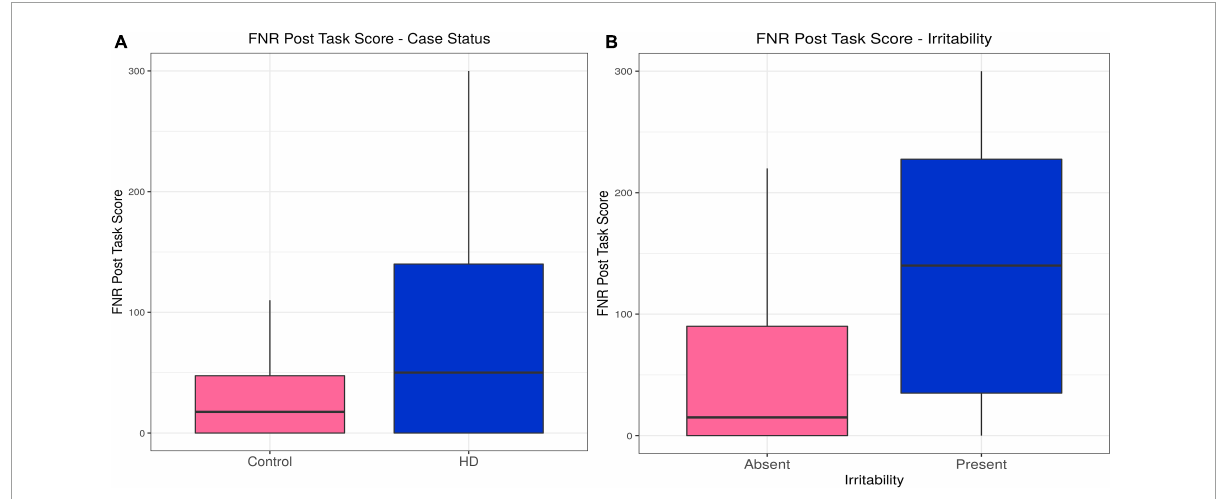
FIGURE3 Frustrative non-reward (FNR)–Effects of case status and irritability status. Box and whisker plots (median, interquartile range, and outliers as individual points). (A) Group differences between Huntington’s (HD) cases and control participants. (B) Group differences between irritable and non-irritable HD